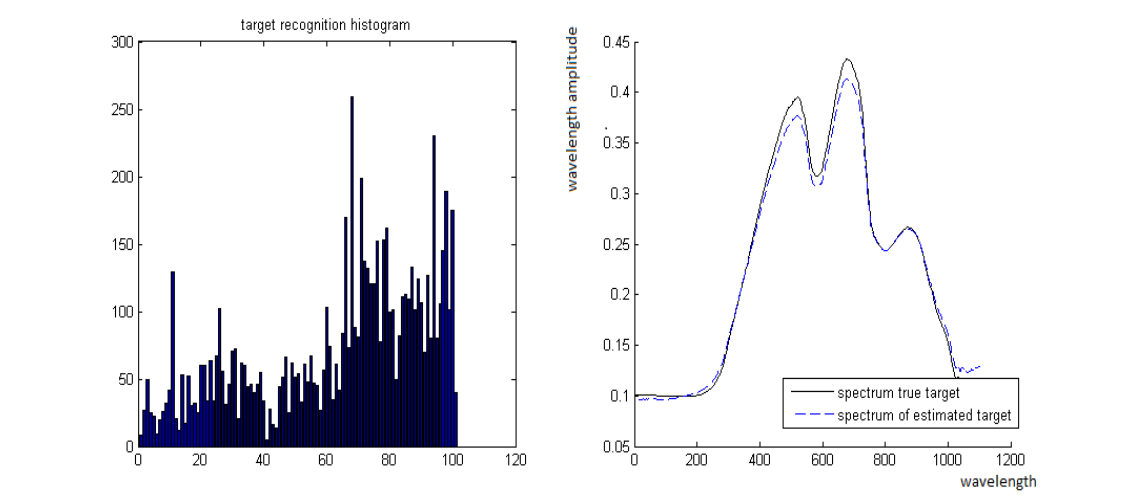
Figure 13. Left: The “unmixing histogram” from Definition 5.1. Right: Comparison between B and its estimation ˆ B